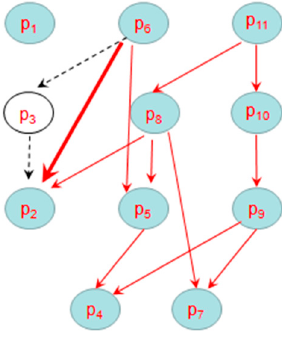
Figure 10. Updating DSG.